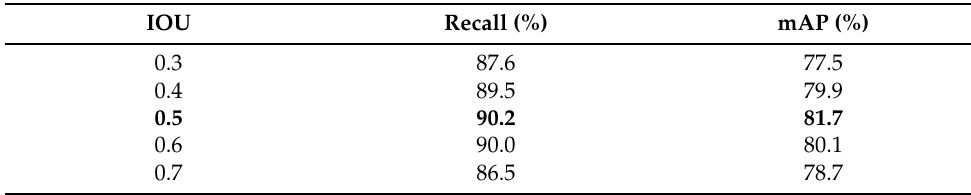
Table 3. The mAP of different IOU.